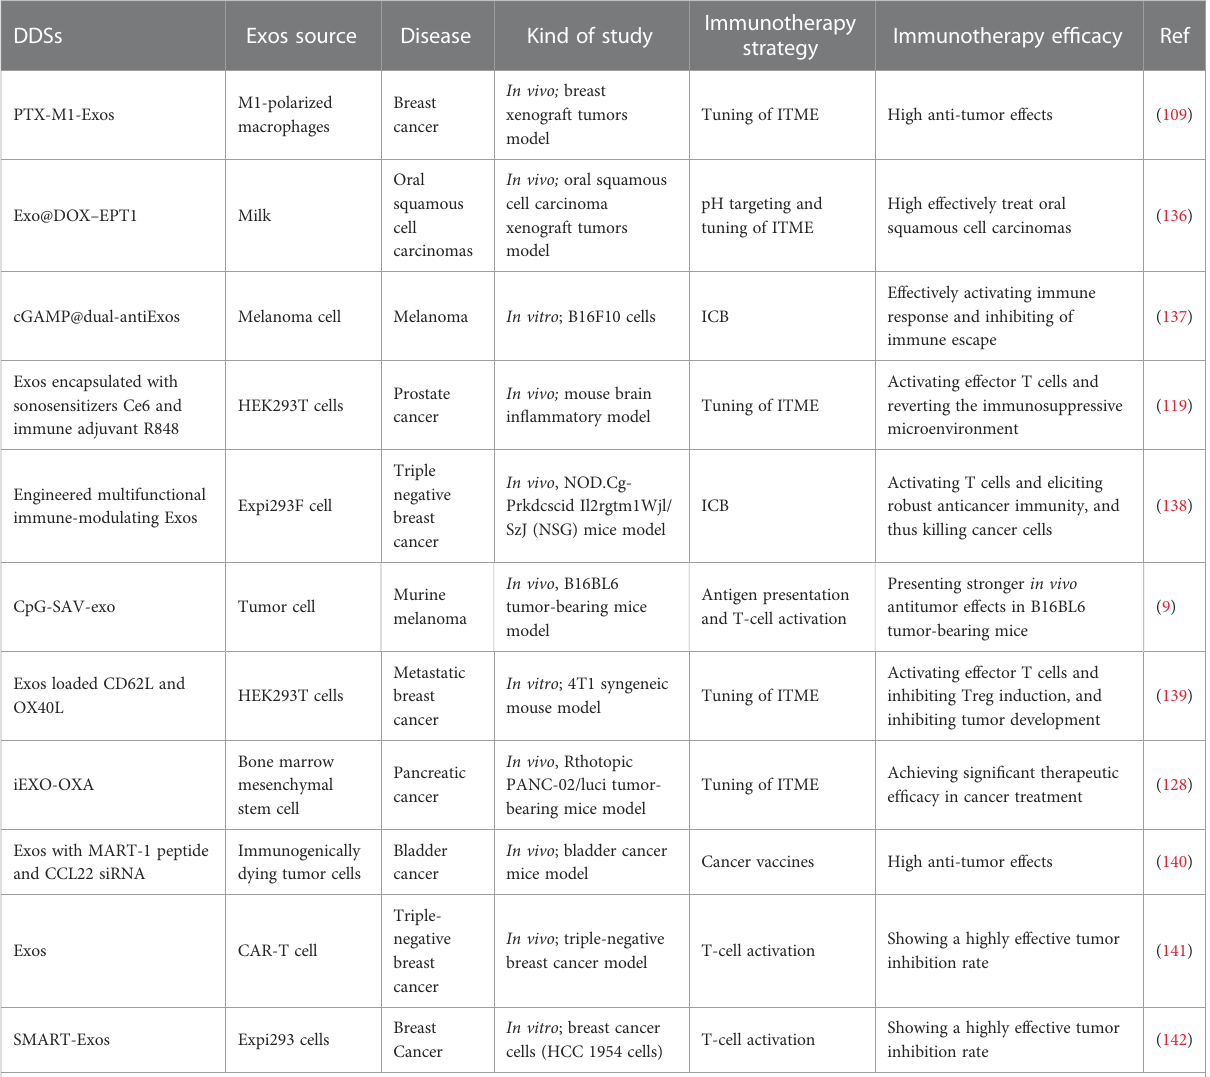
TABLE 2 The samples of Exos-based DDSs for cancer